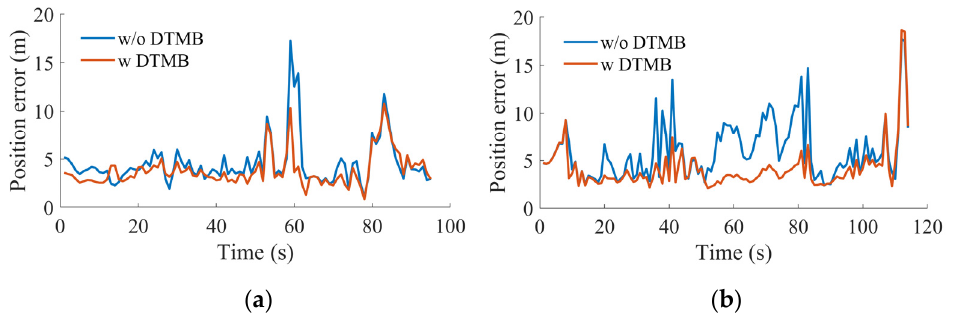
Figure 12. Position error time series. ( a ) Clockwise. ( b ) Counter-clockwise.